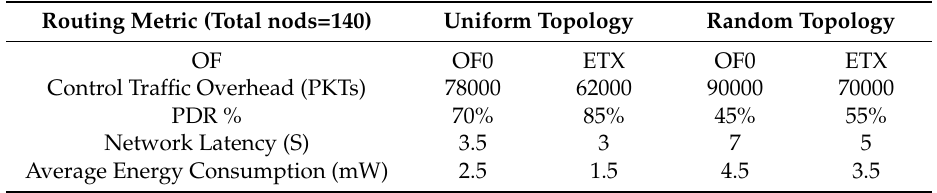
Table 4. RPL routing metrics results in IoT-lab testbed measured over simulation time. Routing Metric (Total nods=140) Uniform Topology